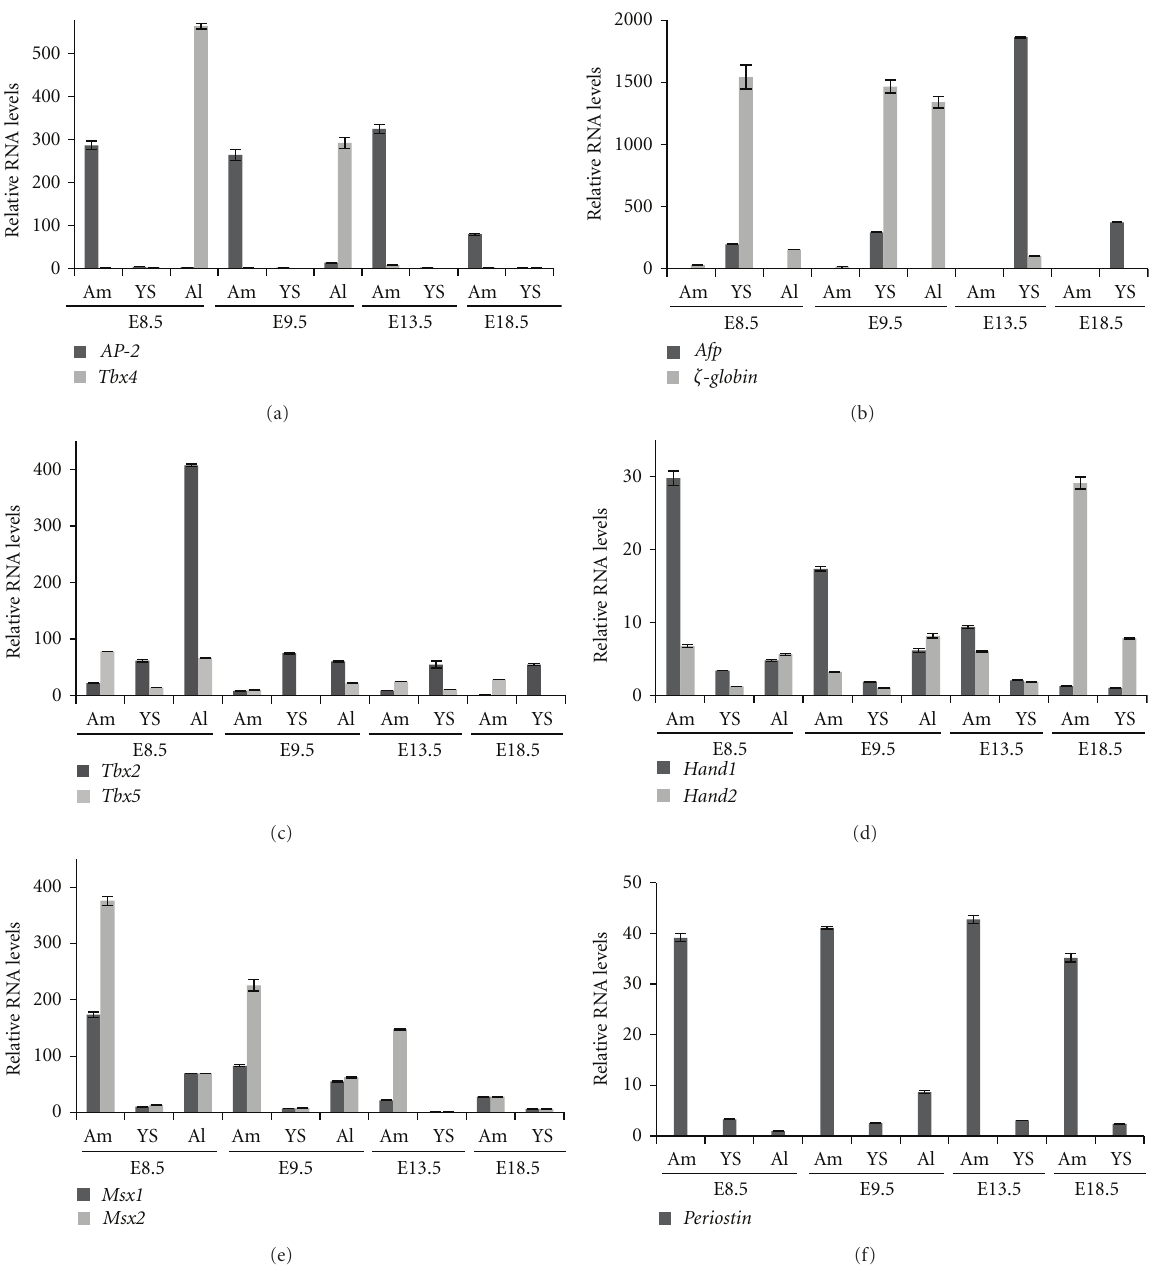
Figure 2: RNA profiling of putative amnion markers in mouse extraembryonic tissues by RT-qPCR. (a)–(b) Validation of microdissected amniotic membrane tissues collected at di ff erent stages of development by relative RNA expression analysis of markers for (a) nonneural ectoderm ( Ap-2 ) and allantois ( Tbx4 ) and (b) primitive red blood cells ( ζ - globin ) and yolk sac endoderm ( Afp ). (c)–(e) Expression analysis of acknowledged target genes of SMAD-mediated BMP signaling ( Tbx2 , Tbx5 , Hand1 , Hand2 , Msx1 , Msx2 ) and (f) Postn , in extraembryonic tissues. Relative RNA levels were obtained by setting the sample with lowest expression for each target to 1. The expression of di ff erent